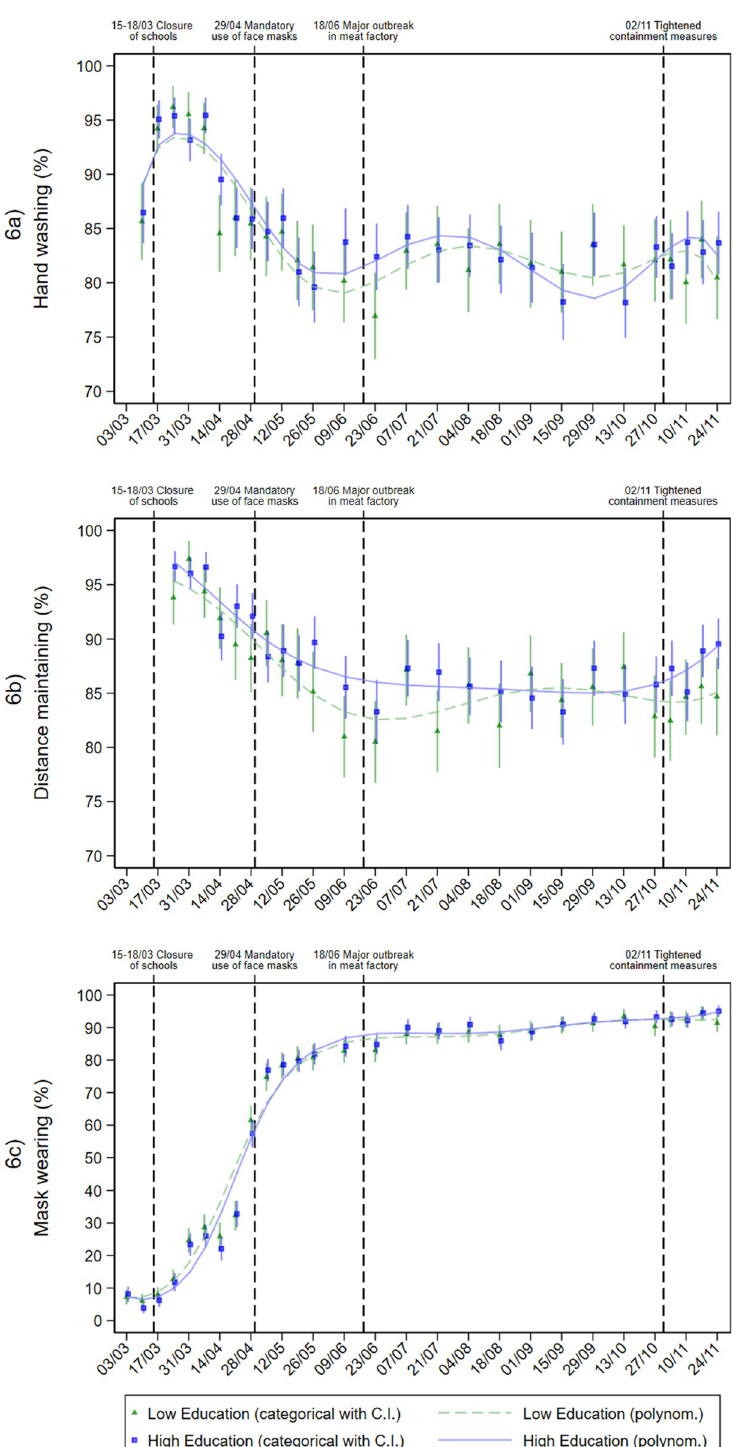
Fig 6. Protective behaviours in individuals with different education levels during the pandemic. Adjusted predictions from logistic regressions with interaction between education level and calendar week (categorial and metric), adjusted for age group, gender, repeat respondent, community size, and federal